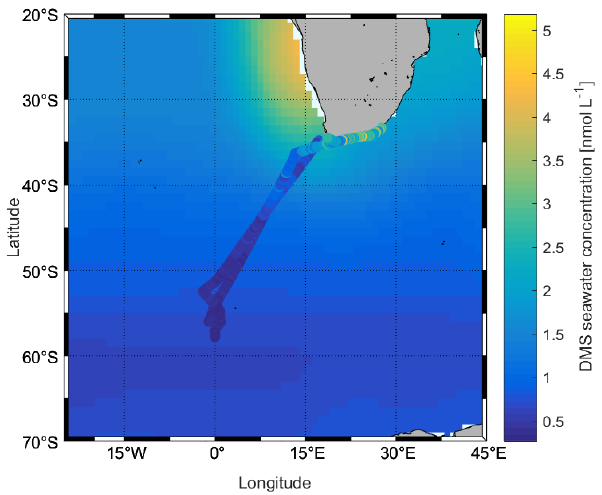
Figure 5. Comparison between measured DMS concentrations (cruise track trace) and those in the Lana et al. (2011) climatology (background) for